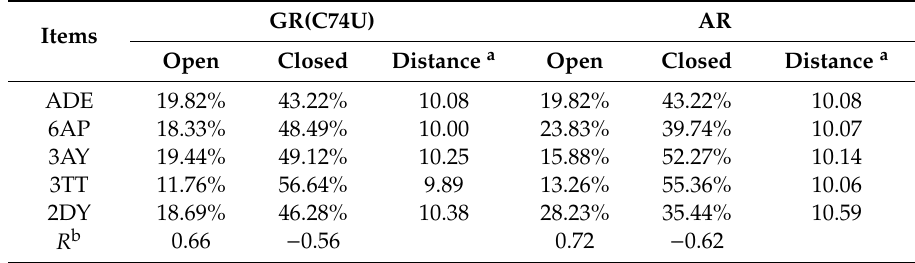
Table 3. The percentages of conformational states and the distances (Å).